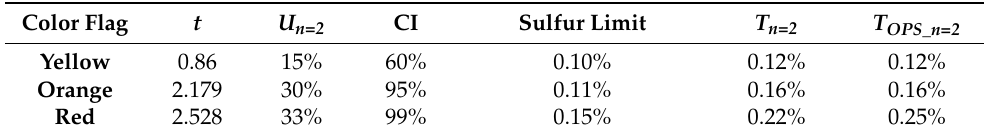
Table 3. Alert flag thresholds based on two subsequent